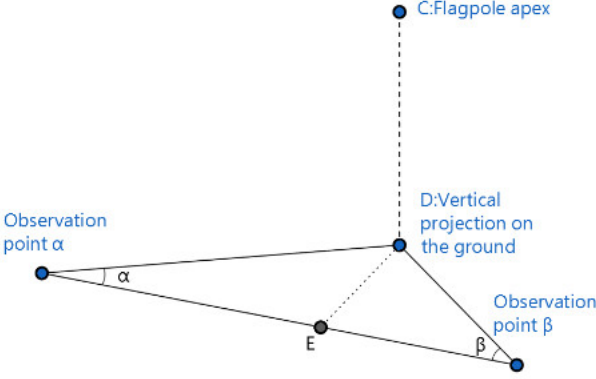
Figure 7. Relative position model of the flagpole and camera.